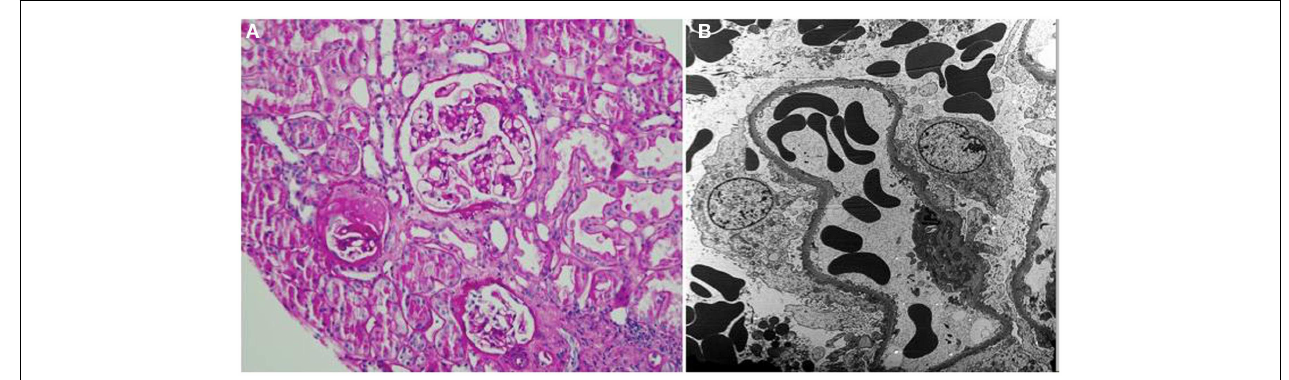
microscopy shows foot process effacement (approximately 30% of the surface area) and reactive cytoplasmic changes in podocytes. Numerous red blood cells are present in the capillary loops and Bowman’s space ( × 3000).